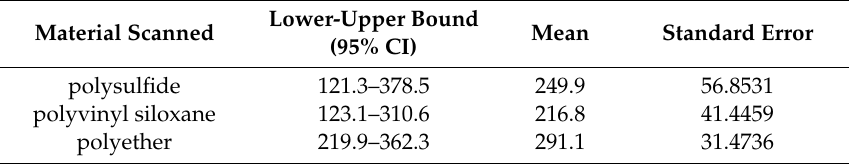
Table 1. Descriptive statistics for trueness ( µ